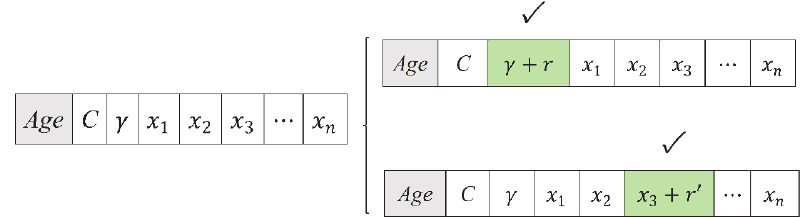
Fig. 3. Example of local seeding operator in GSMOFOA with 𝐿𝑆𝐶 = 2